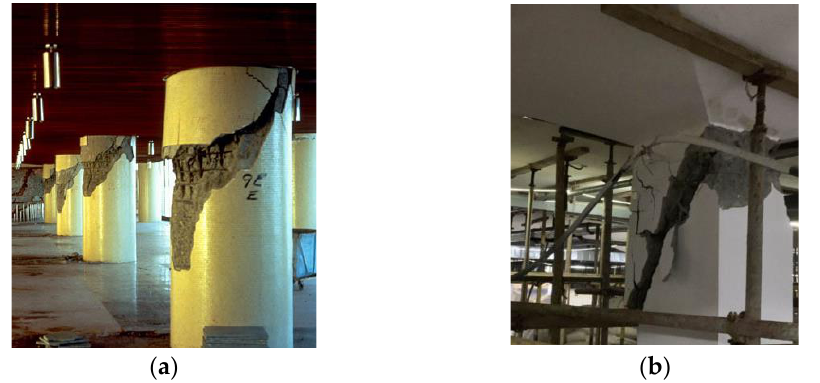
Figure 1. Shear failure of concrete short columns. ( a ) Circular concrete short columns; ( b ) Cubic concrete short columns.